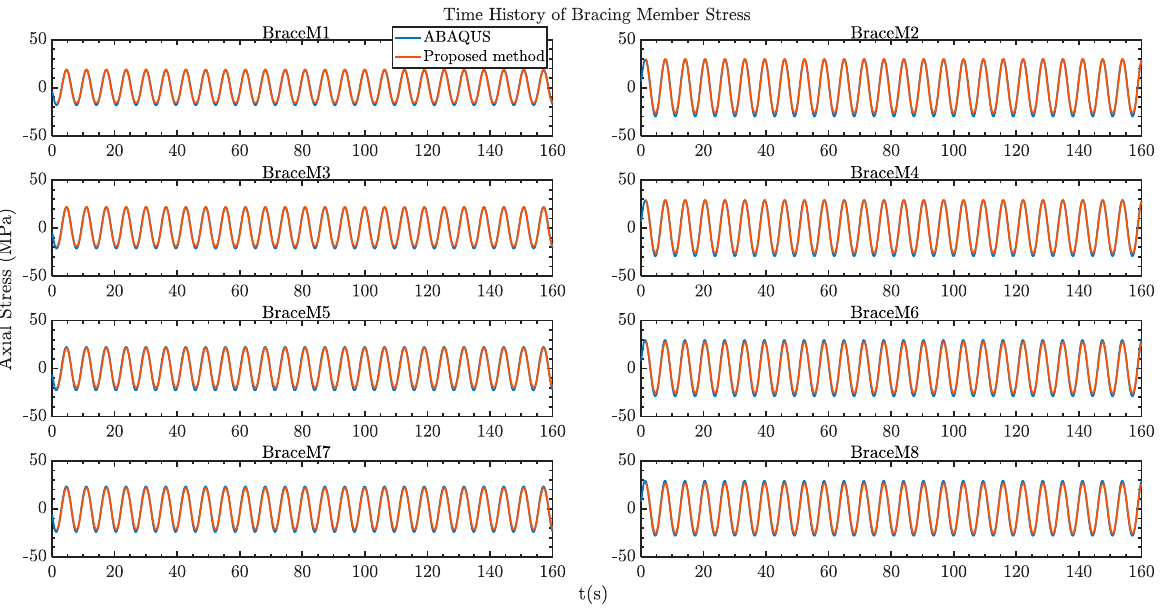
Figure 10. Comparison of the time history of bracing member axial stresses under regular wave excitations.